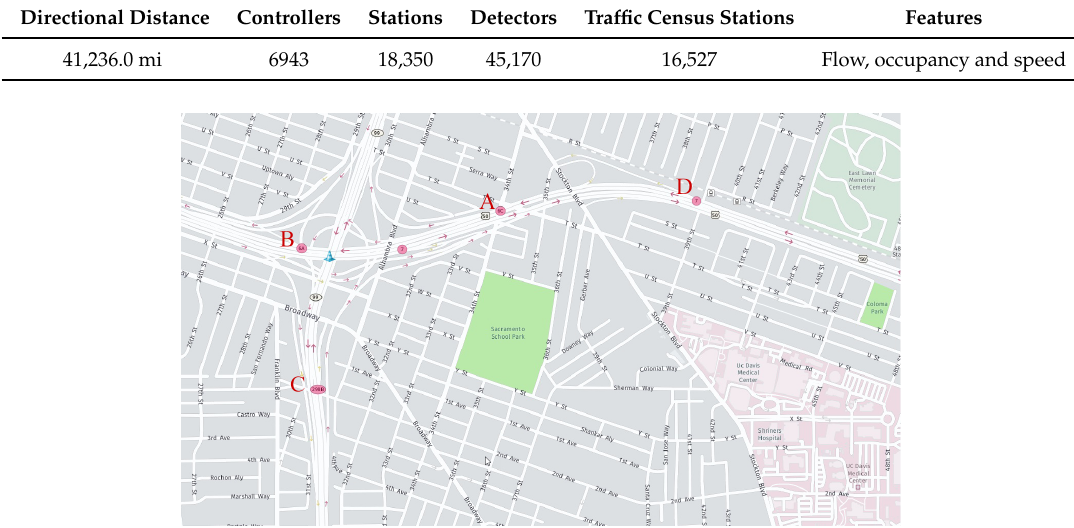
Figure 4. The data are collected around Sacramento County. The data collection stations are set up on the mainline of the four